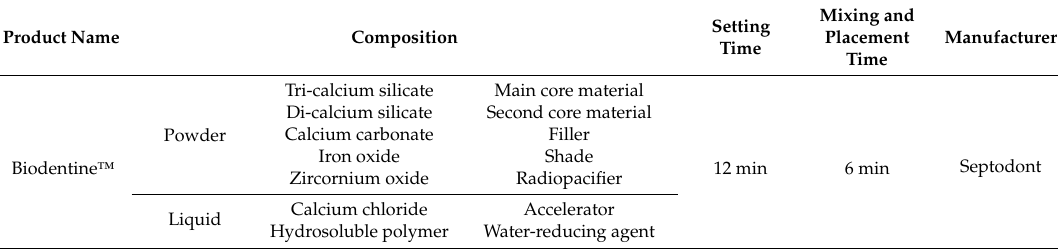
Table 1. Composition and setting time of Biodentine ™ as specified by the